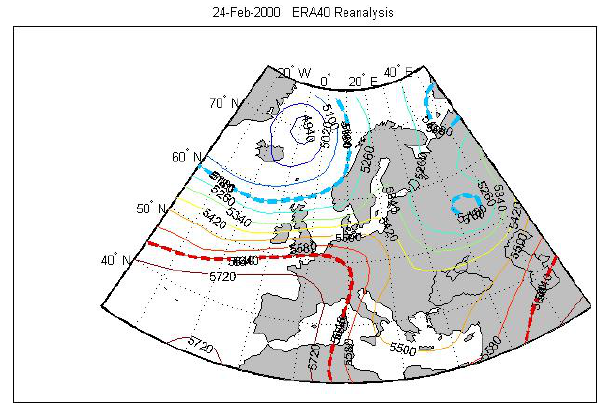
Fig. 3. Frequency of occurrence of the 36 clusters.